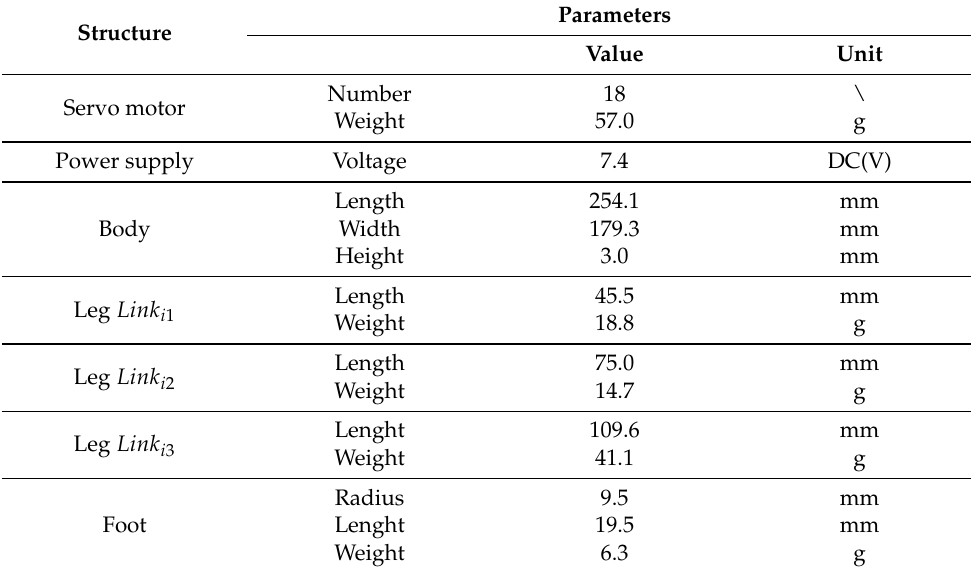
Table 1. Technical specifications of the hexapod robot prototype.